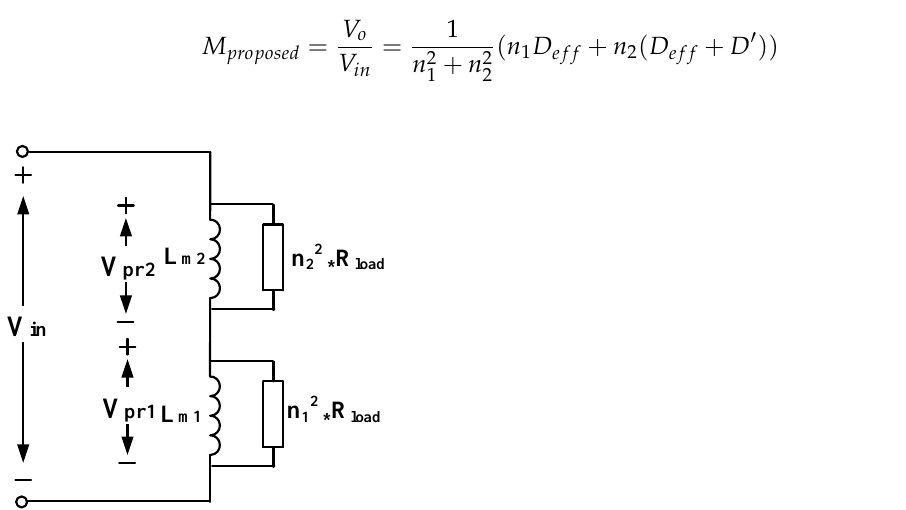
Figure 6. Equivalent circuit to show the voltage conversion ratio of the proposed LDC.